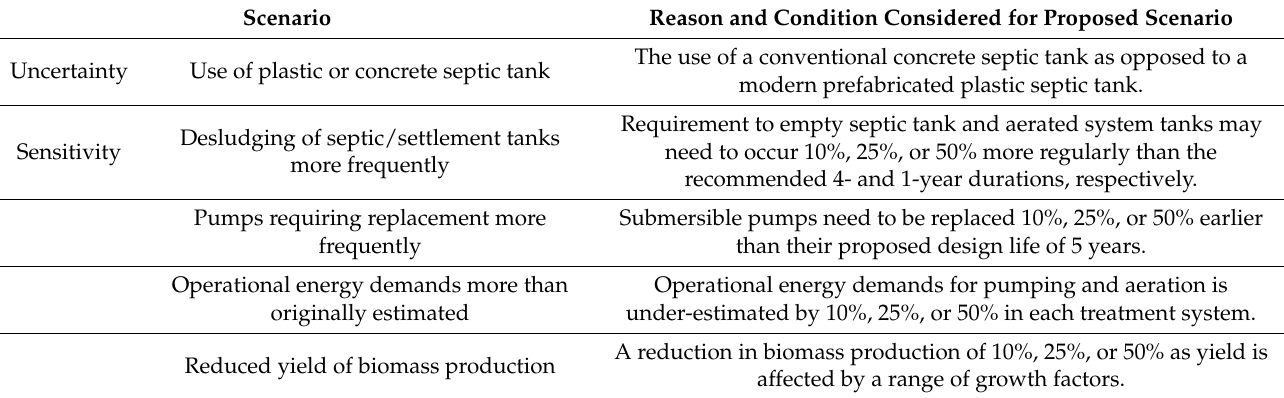
Table 3. Scenarios of uncertainty and sensitivity of construction and operational burdens of DWWTS. Scenario